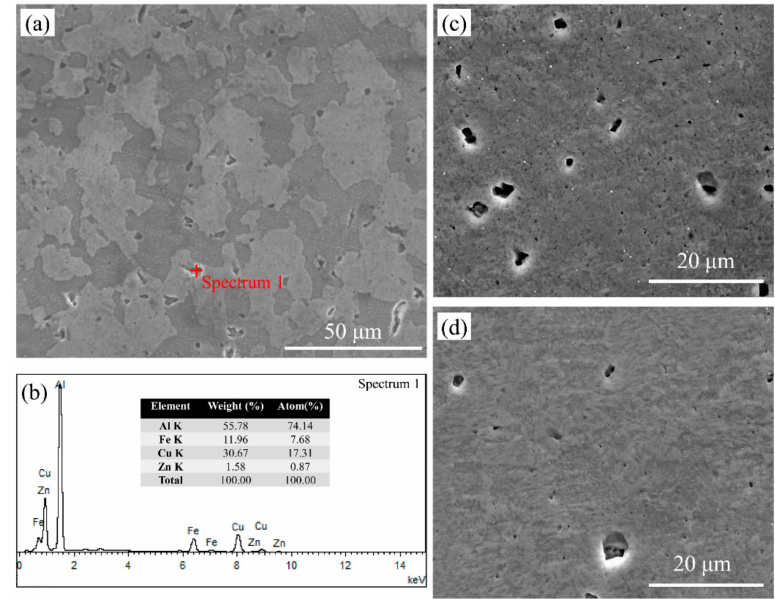
Figure 6. SEM micrographs of ( a ) the ST Al 7075 alloy; ( c ) the CT-LSEM sample; and ( d ) the RT-LSEM sample; ( b ) EDS results of the particle phase marked in Figure 7a.